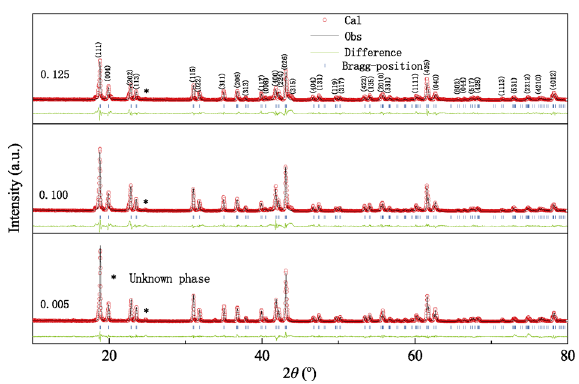
Fig. 3 Characteristic Raman spectra of Li 3 Mg 2 Sb 1– x O 6 ceramics fired under various temperatures: (a) Li 3 Mg 2 Sb 0.95 O 6 , 1250 ℃ , (b) Li 3 Mg 2 Sb 0.9 O 6 , 1200 ℃ , (c) Li 3 Mg 2 Sb 0.9 O 6 , 1225 ℃ , (d) Li 3 Mg 2 Sb 0.9 O 6 , 1250 ℃ , (e) Li 3 Mg 2 Sb 0.9 O 6 , 1275 ℃ , and (f) Li 3 Mg 2 Sb 0.875 O 6 , 1250 ℃